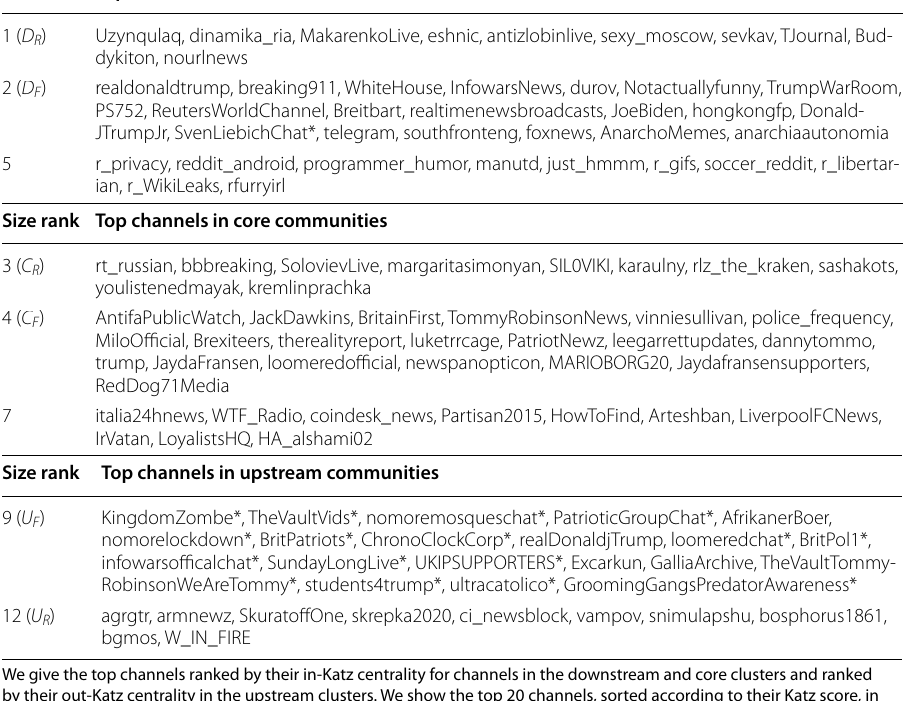
Table 3 Most important channels in the main downstream, core and upstream clusters for the network G 2 in Fig. 5 corresponding to the period July 2019 to Feb. 2020 Size rank Top channels in downstream